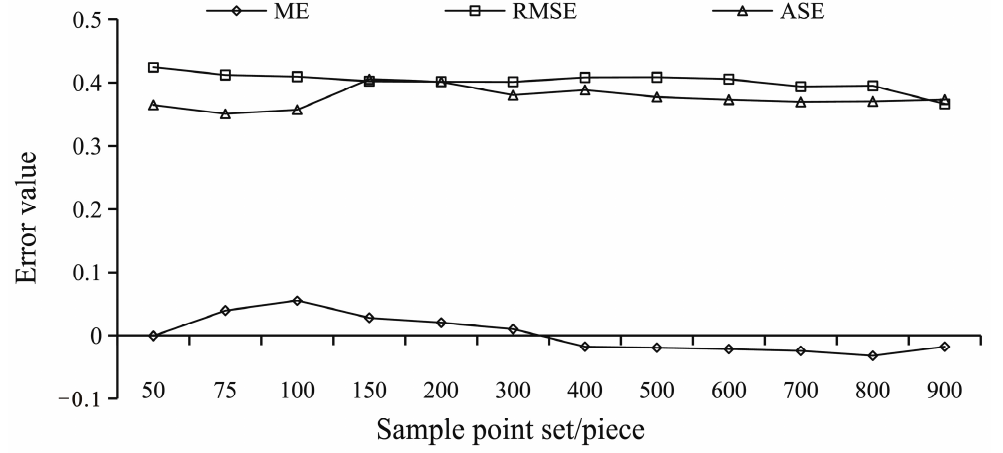
Figure 3. Prediction error of soil pH at different point sets.